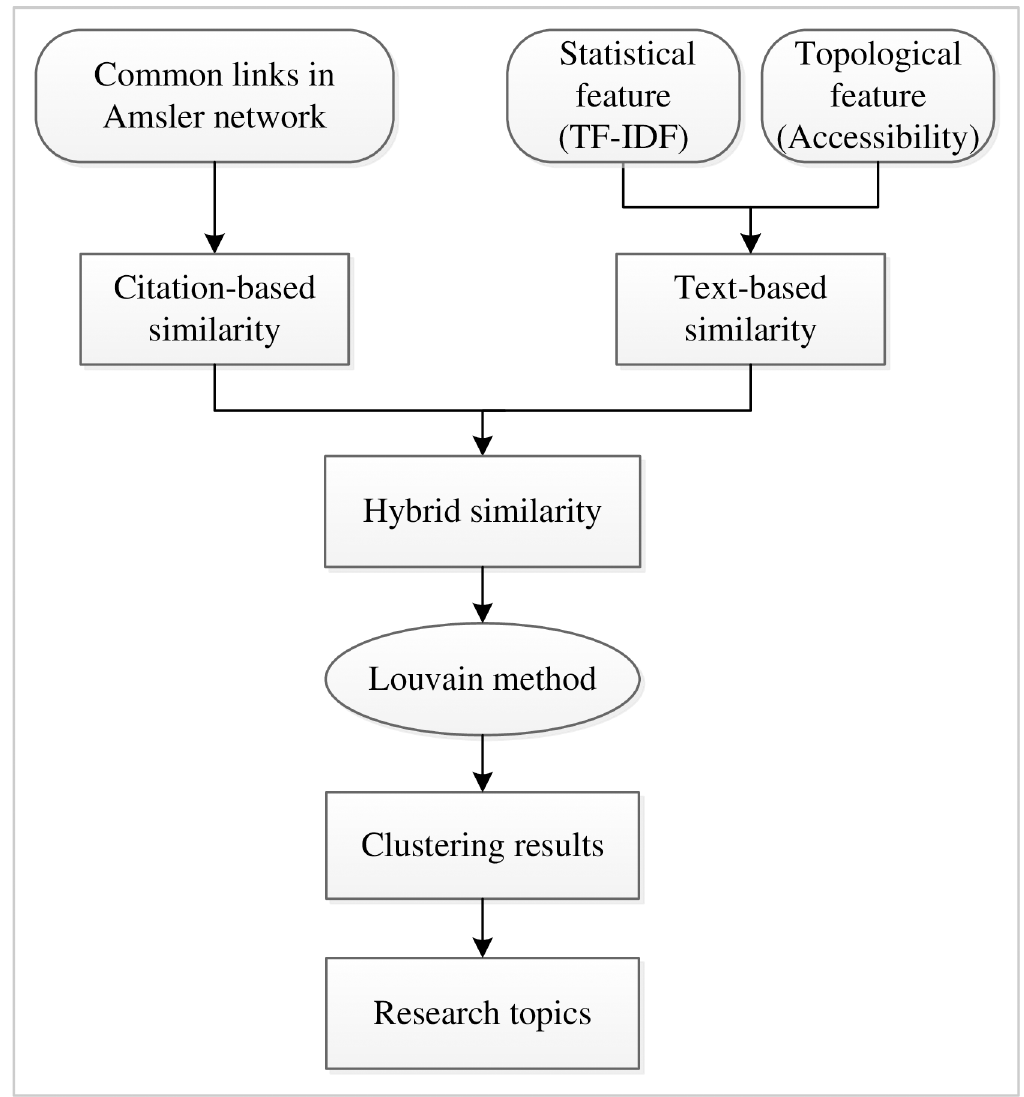
Fig 1. Flowchart of the proposed hybrid self-optimized clustering